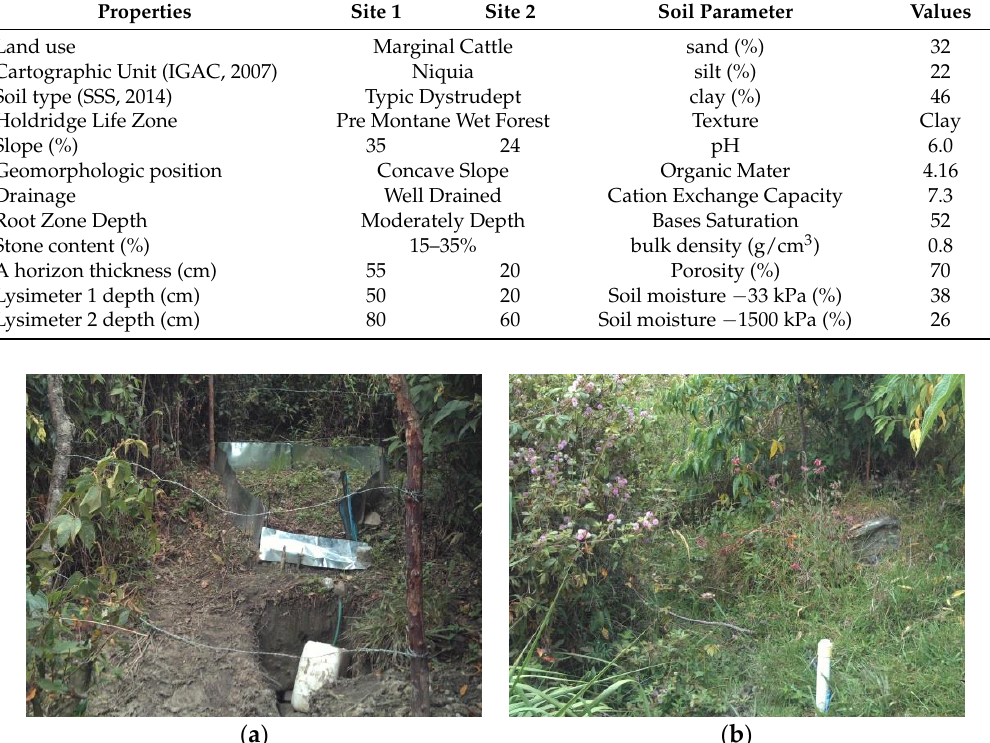
Figure 3. Some characteristics of the instrumentation: ( a ) runoff plot; two zero-tension lysimeters were installed at different depths within the plots; and ( b ) one of the four piezometers installed along the slope. Table 1. Soil physical and chemical properties and instrumentation characteristics of the study plots. Adapted from [15].